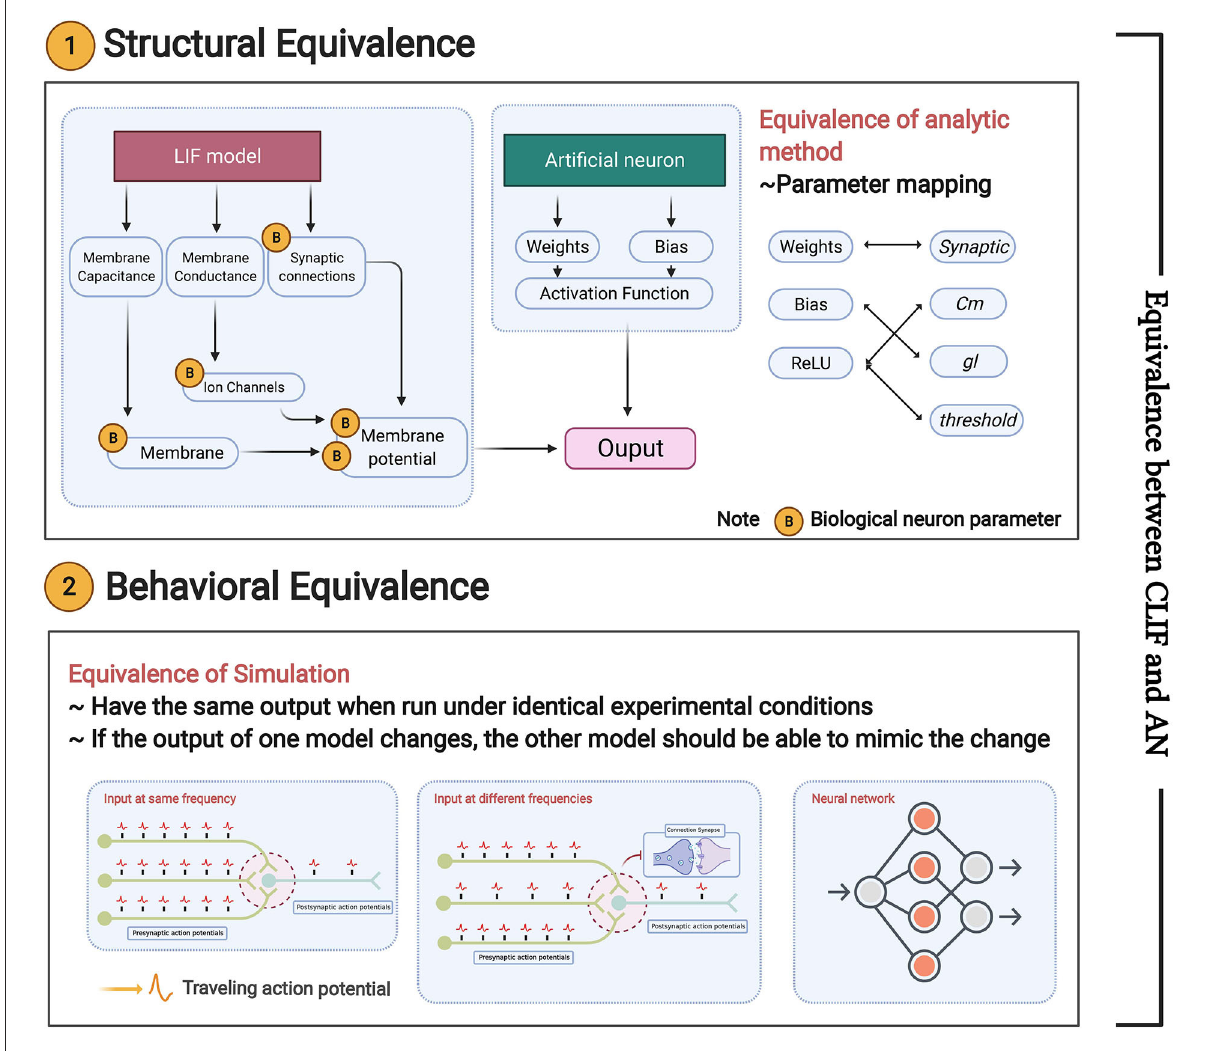
FIGURE4 Equivalence between Linear LIF/SNN model and ReLU/ANN: structural equivalence and behavioral